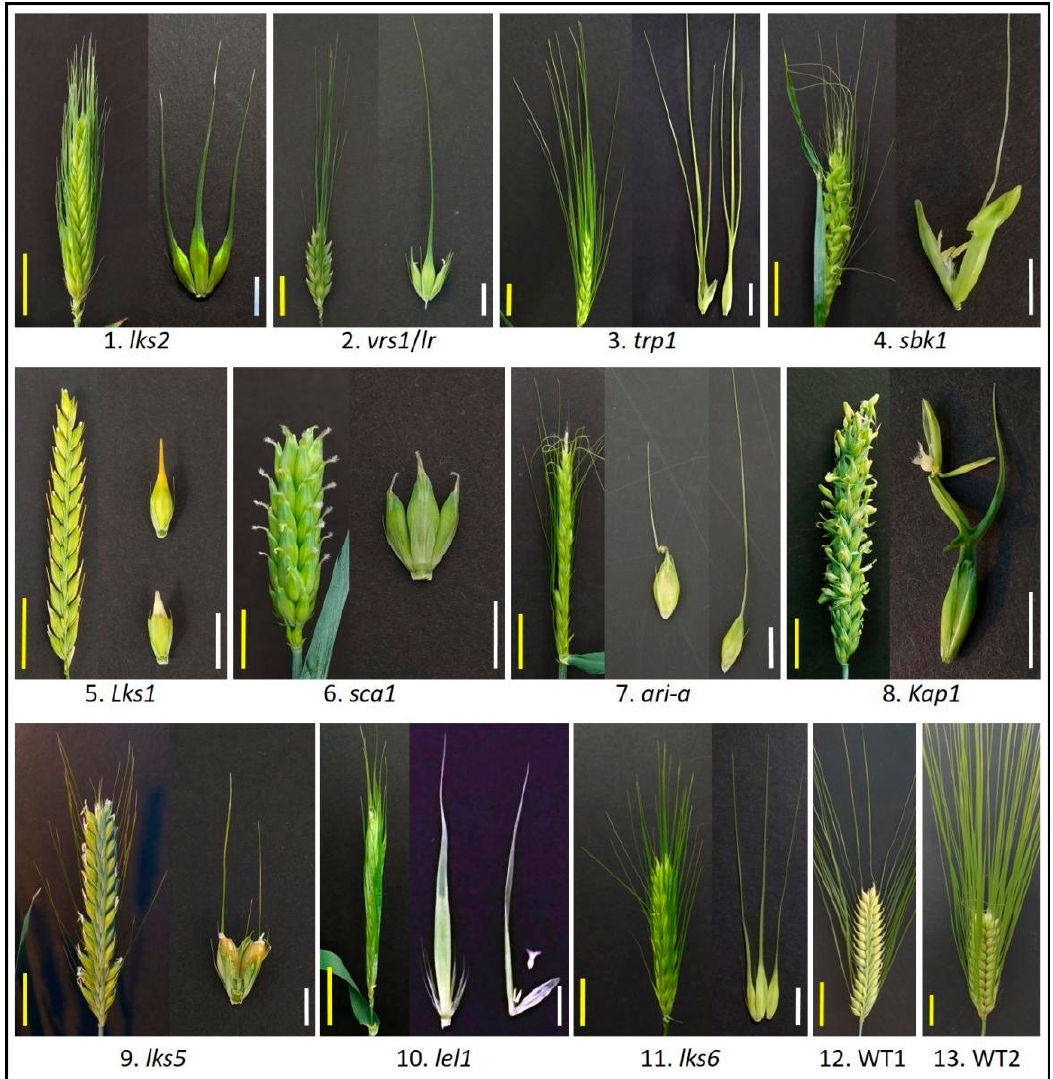
Figure 1. Barley awn diversity. Barley awn mutants obtained from the National Small Grains Collection, USDA-ARS (Agricultural Research Service, United States Department of Agriculture), Aberdeen Idaho. 1 - lks2 , short awn; 2 - vrs1 ( lr ), six-rowed with awnless lateral spikelet; 3 - trp1 , triple awned lemma; 4 - sbk1 , subjacent hooded lemma; 5 - Lks1 , awnless; 6 - sca1 , short crooked awn; 7 - ari-a , short awn; 8 - Kap1 , hooded lemma; 9 - lks5 , short awn; 10 - lel1 , leafy lemma; 11 - lks6 , short awn; 12 -WT1, wild type, two-rowed with long awn; 13 -WT2, wild type, six-rowed with long awn. Yellow scale bar = 3 cm; White scale bar = 1 cm.